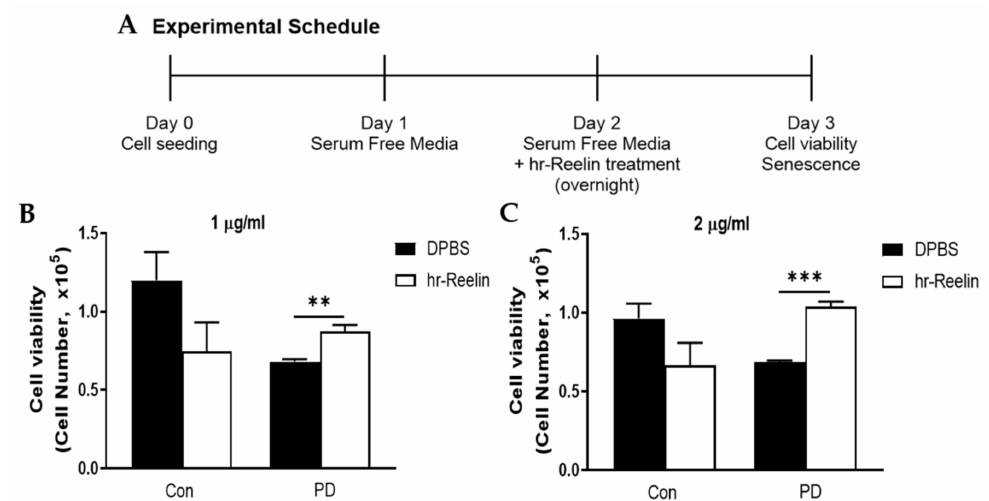
Figure 5. Cell viability at passage 8 following treatment with human recombinant Reelin (hr-Reelin) protein. ( A ) Experimental schedule and method for in vitro treatment with hr-Reelin proteins. ( B , C ) Viability of control and Parkinson’s disease (PD) cells. ( B ) Treatment with phosphate-buffered saline (DPBS) or hr-Reelin proteins at 1 µ g/mL. ( C ) Treatment with DPBS or hr-Reelin proteins at 2 µ g/mL. n = 5 for control group, n = 4 for PD group. Mean ± S.E.M. Student’s t -test, ** p < 0.01; *** p < 0.001.